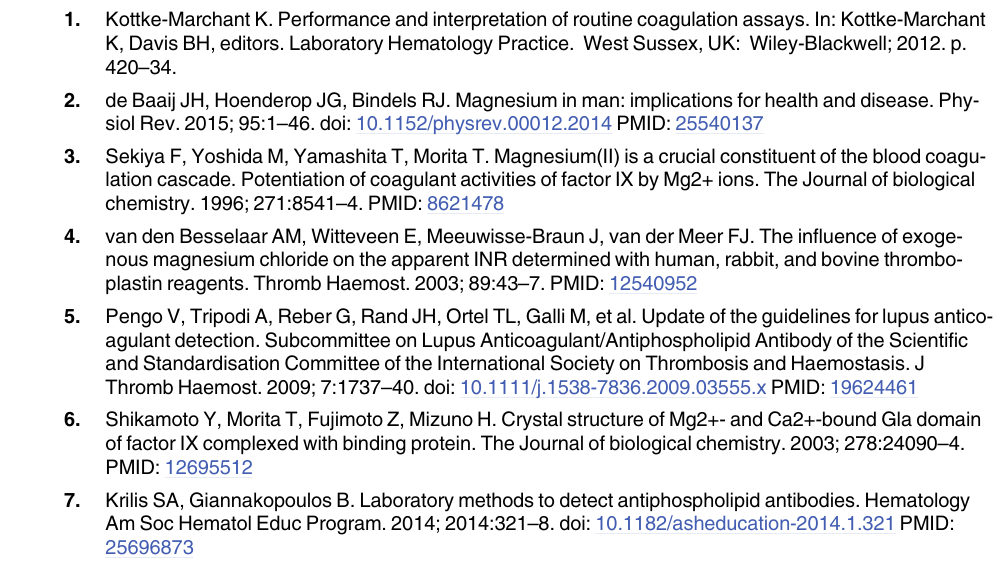
Ca-APTT: APTT obtained without exogenous magnesium, Mg/Ca-APTT: APTT obtained with 8.3 mmol/L exogenous magnesium, open circles: samples that exhibited APTT pro- longation after the addition of magnesium (n = 210), closed circles: samples that demon- strated APTT shortening after the addition of magnesium and were also positive for lupus anticoagulant (n =